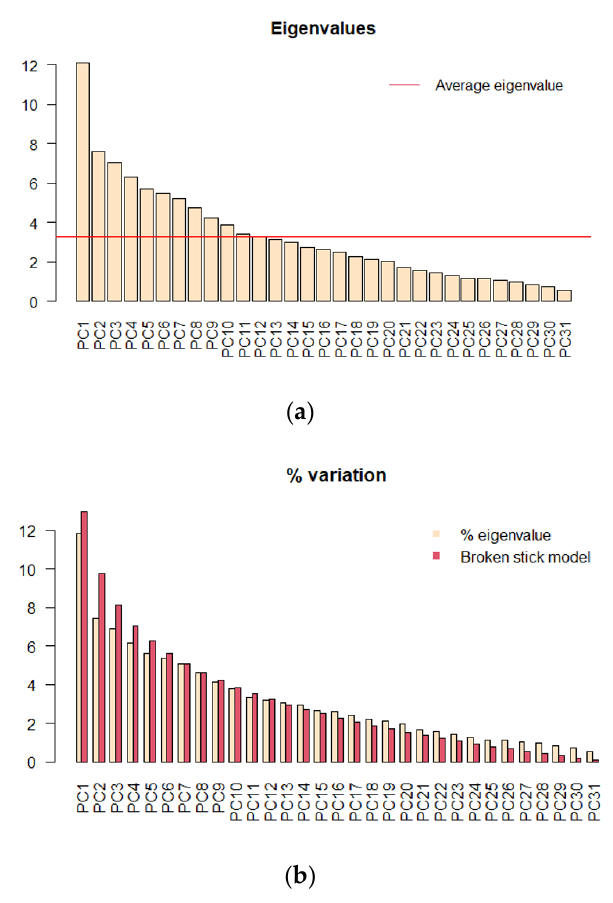
Figure 1. Instrument validation. ( a ) Kaiser–Guttman criteria; ( b ) Broken-stick criteria.